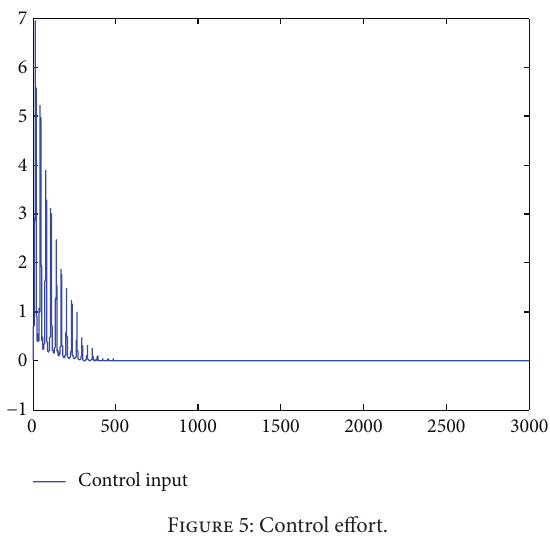
Figure 5: Control